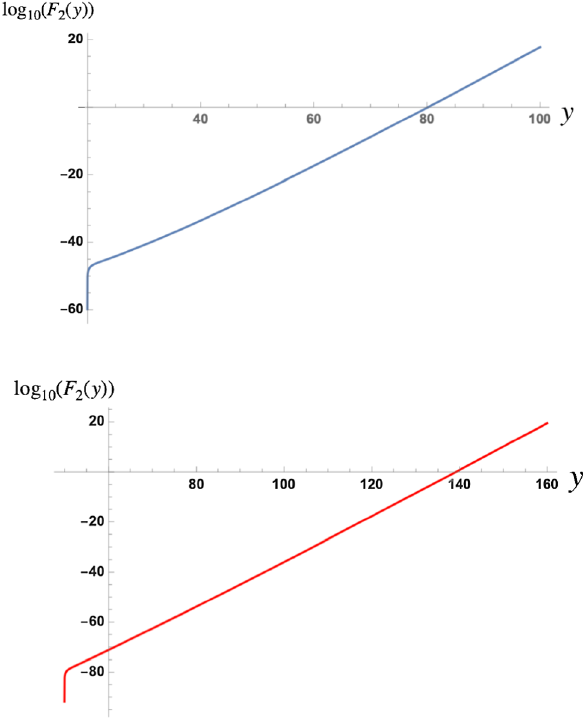
Fig. 3 Log of the ratio of the calculated number density of X -particles to the equilibrium number density (4.5) calculated in the limit n X (cid:11) n eq ; left panel: y in = 20 and right panel: y in =